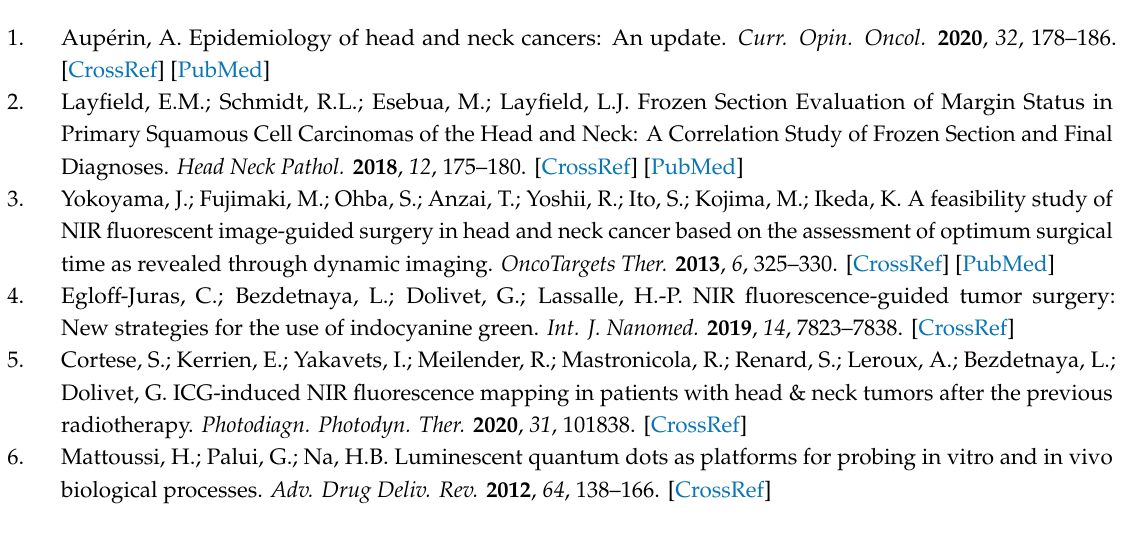
Figure S1: Colorimetric assay of the e ffi ciency of the conjugation of the N 3 -A20 peptide to the accessible reactive moieties. Figure S2: Photoluminescence excitation spectrum from the NIR QDs (detection at 750 nm). Figure S3: Fluorescence decay of QD before and after functionalization with DBCO and A20 peptides. Figure S4: Flow cytometry histograms of FaDu and MeWo cells from co-culture (F5M5) spheroids exposed for 3 h to 50 nM A20-QDs. Figure S5: The adjusted MFI values (autofluorescnece subtracted) of FaDu and MeWo cells from co-culture (F5M5) spheroids exposed for 3 h to 50 nM of SPP-QDs and A20-QDs. Figure S6: Quantitative analysis of fluorescence images captured with and without time-dated